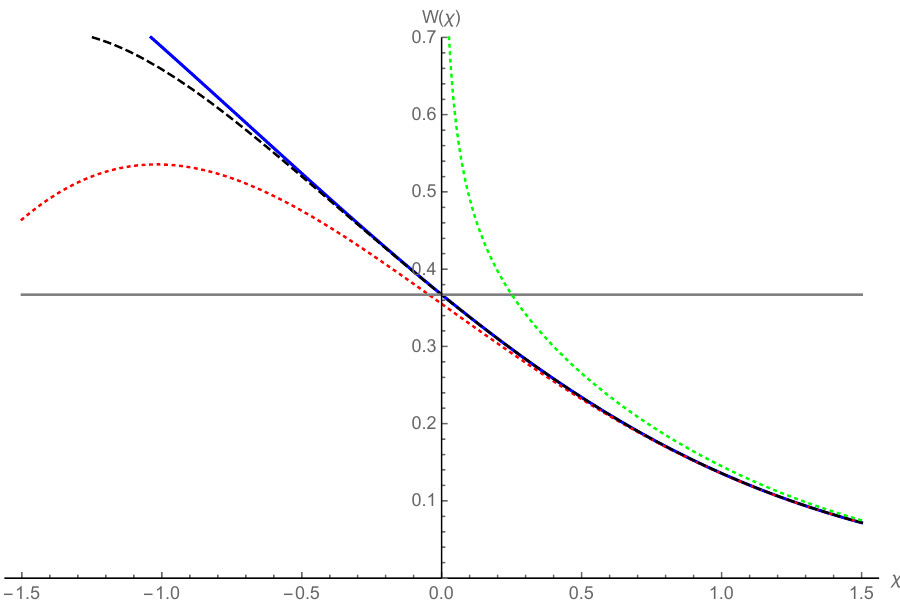
Figure 16 . Illustration of the instanton condensation phenomenon for the Painlev(cid:19)e II equation, which characterizes the immediate vicinity of the GWW phase transition. The solid blue curve is the exact (numerical) solution of the Hastings-McLeod solution to the Painlev(cid:19)e II equation (6.1), (with parameter a = 0). The red dotted curve is the uniformized leading instanton contribution W ( (cid:31) ) = Ai( (cid:31) ), and the black dashed curve includes also the uniformized three-instanton contri- (1) bution in (6.15). The horizontal grey line is the numerical value [86, 87, 95, 96] at the transition point (cid:31) = 0: W (0) = 0 : 36706155, which agrees to 0 : 1% precision with the (cid:12)rst two terms of the trans-series (6.14). The dotted green line, which diverges at the transition point, is the conventional leading one-instanton approximation, from the leading large (cid:31) behavior of the Airy